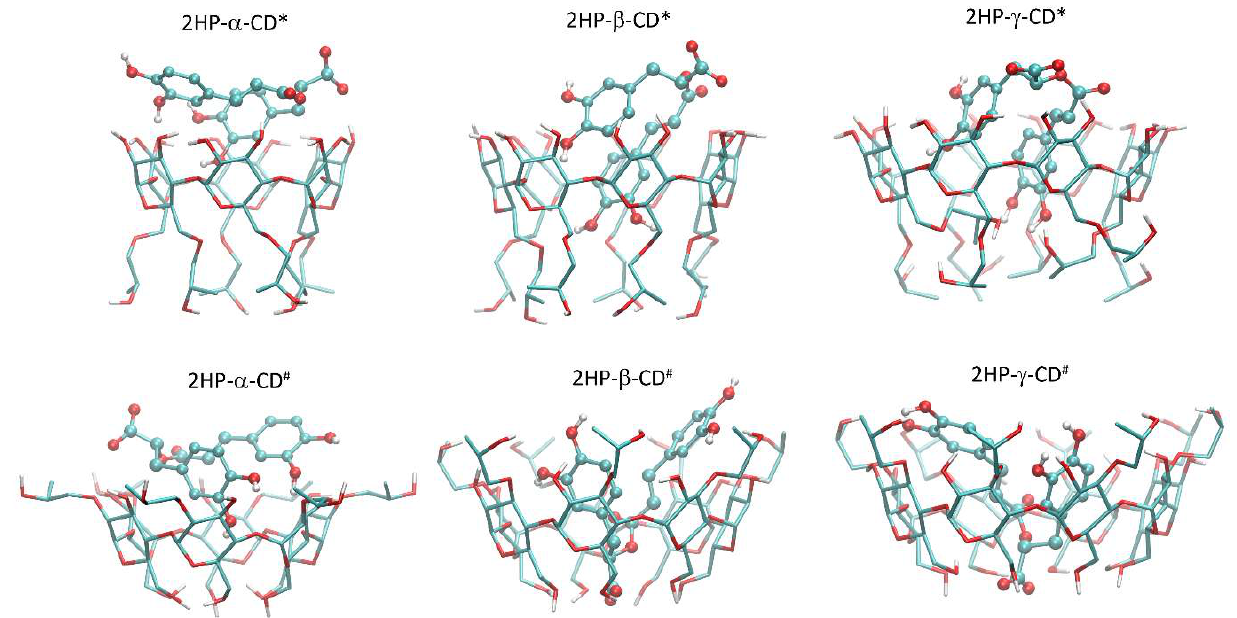
Figure 5. The graphical illustration of the RA–CD systems identified during the docking study. The shown structures are representative of the given type of host molecule. The guest (RA) molecule is shown in a ball-and-stick representation, whereas the host (various derivatives of CDs) molecules are presented in stick representation. Aliphatic hydrogen atoms are omitted for clarity. #: 2-HP-CD# containing all 2-HP groups substituted to the O(2) hydroxyl oxygen atoms of CD (atom numbering in accordance with the IUPAC recommendations); *: 2-HP-CD* containing all 2HP groups